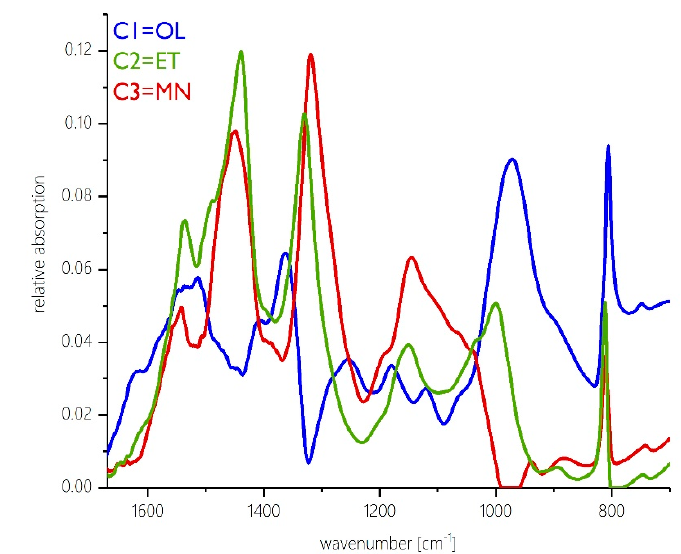
Figure 2. Spectral fingerprints extracted from the original reaction spectra via MCR representing the three invariable absorbance patterns OL (blue), ET (green) and MN (red) comprising the overall spectral information during MF resin cure .